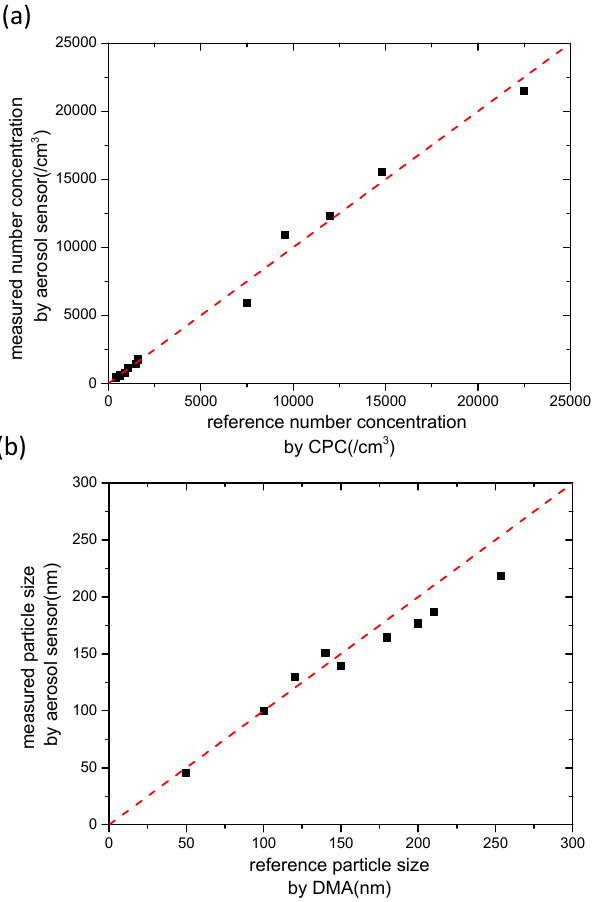
Figure 6. ( a ) Comparison of results measured by the aerosol sensor and reference data determined by CPC for number concentration; and ( b ) comparison of results measured by the aerosol sensor and reference data determined by DMA for particle size.